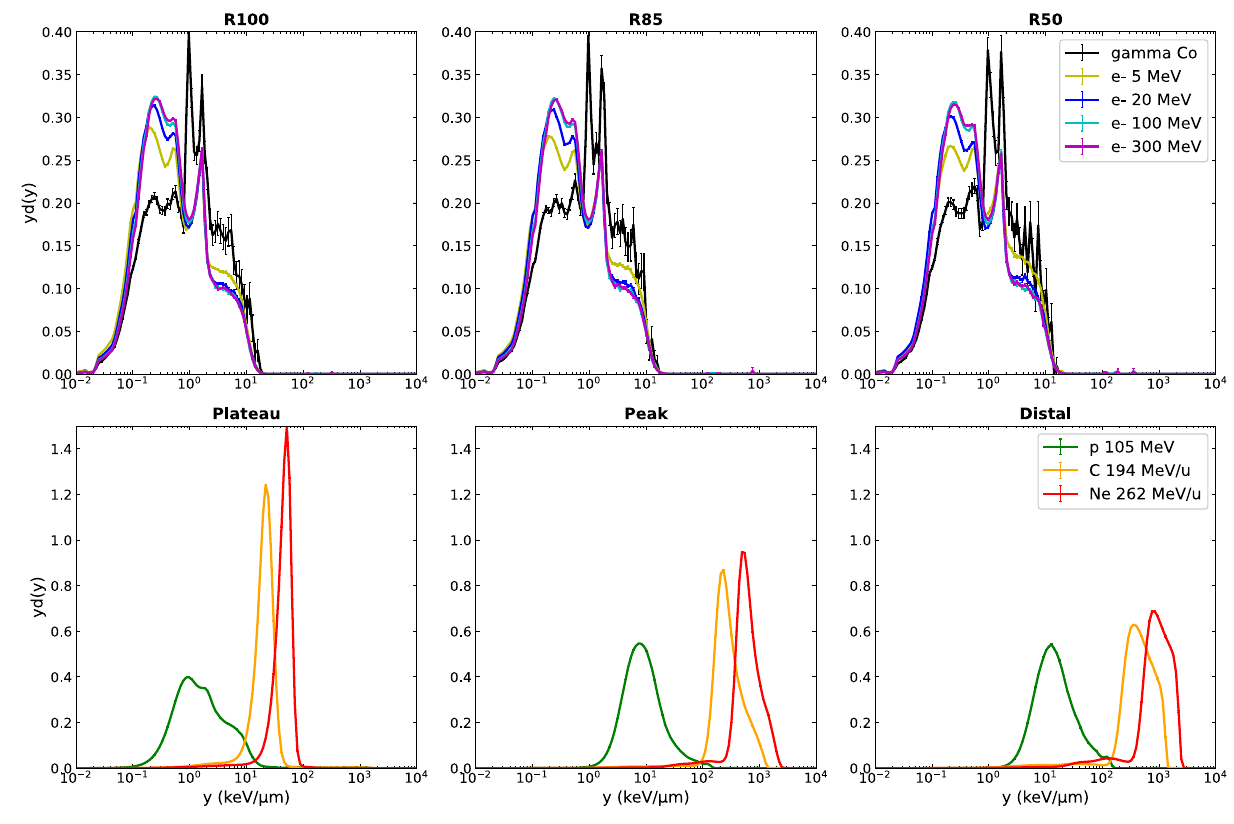
Figure 4. Comparison of microdosimetric spectra yd(y) for photon and electron beams (upper panel), and proton and ion beams (lower panel) calculated at characteristic depths.